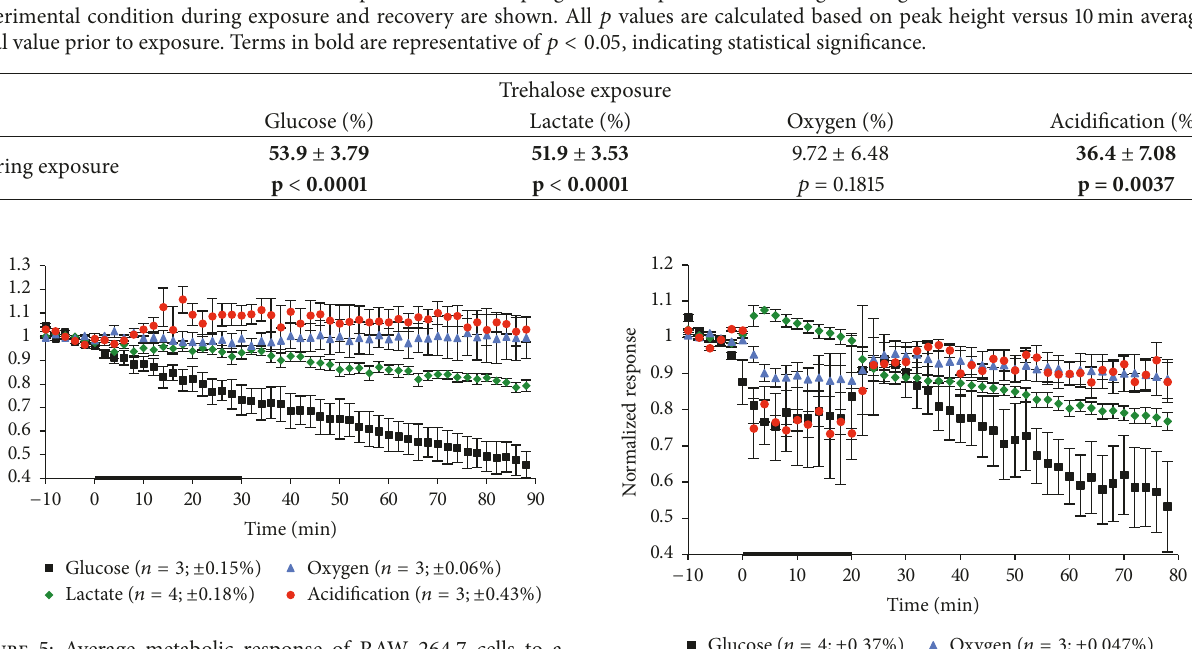
Figure 5: Average metabolic response of RAW 264.7 cells to a 30 min exposure of 3 𝜇 mol/L CpG-DNA. The black bar indicates the exposuretime.Thenumberofexperimentsandstandarderrorofthe mean for the basal metabolic rate 10min before exposure to CpG- DNA are given in parentheses.